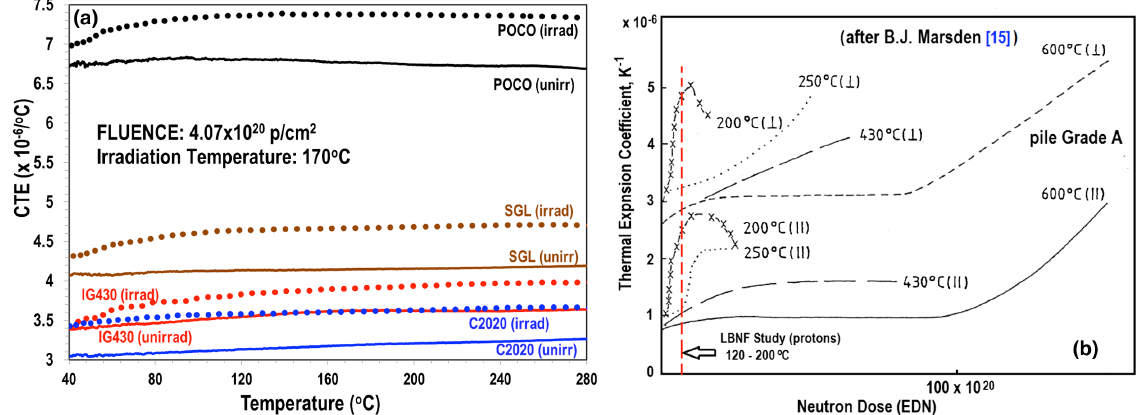
FIG. 10. Irradiation-induced changes in the CTE. (a) LBNF graphite grades irradiated at 170 °C and (b) pile grade A graphite (after Marsden [11]).